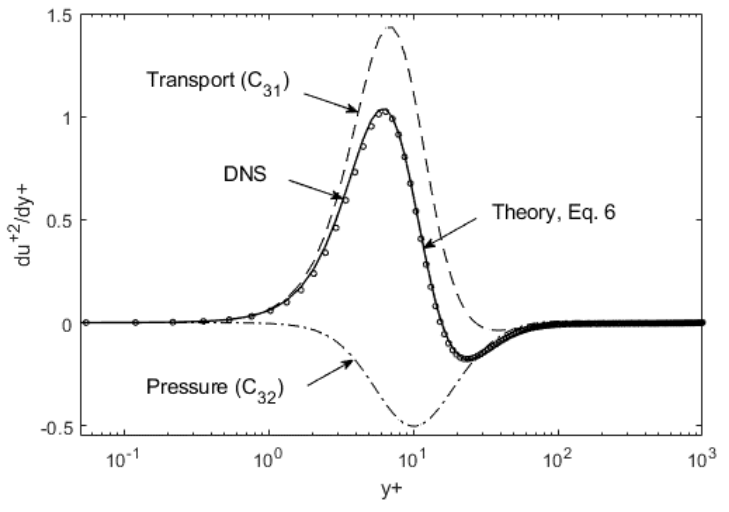
Figure 8. The energy flux budget for u’ 2 -gradient. Contributions from individual terms in Equation (6) are plotted as different lines (e.g., transport is the C 31 term). Again, DNS data [12] are used for confirmation of Equation (6).